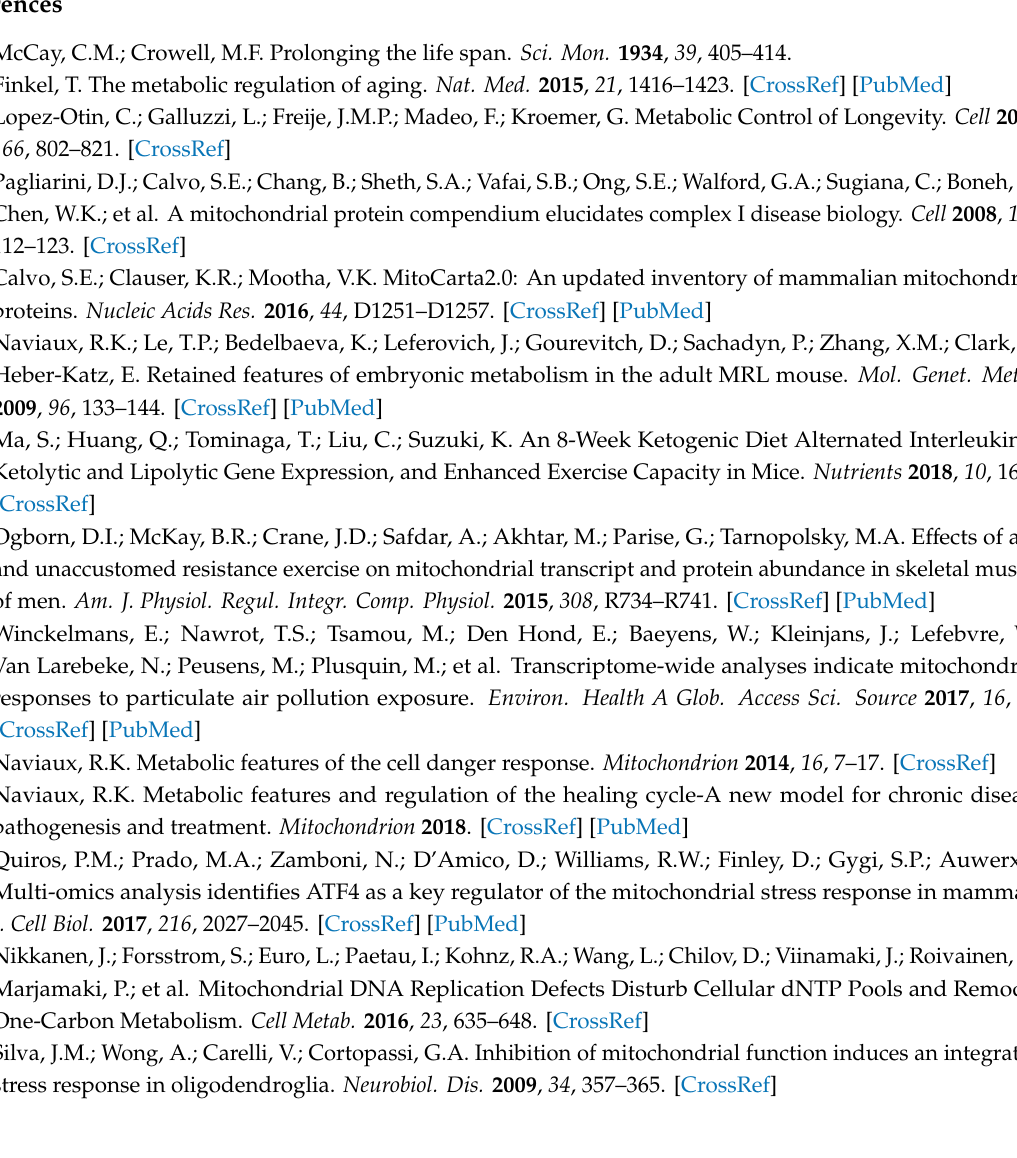
Table S1: The mitochondrial proteome and nucleotide